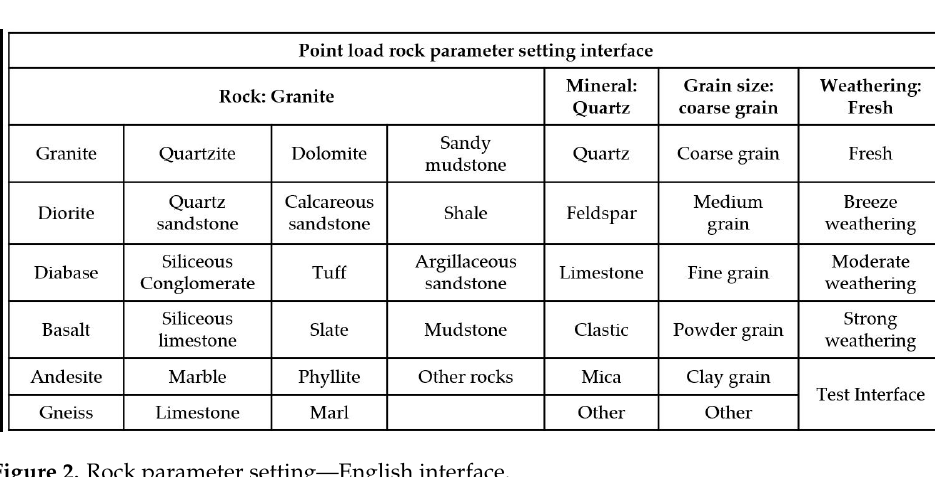
Figure 2. Rock parameter setting—English interface.